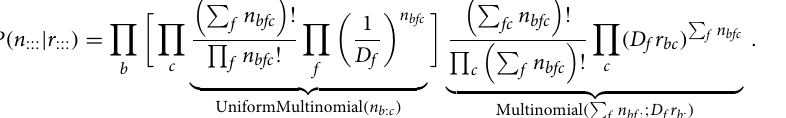
} , where D b , D f and Db f Df c Dc